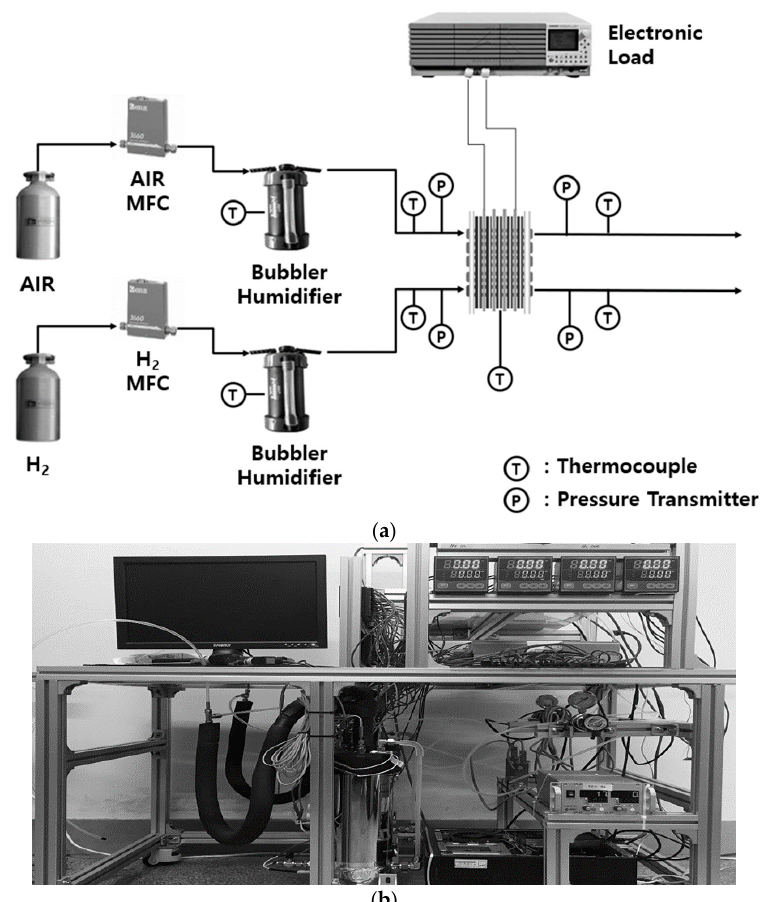
Figure 2. ( a ) Schematic of the polymer electrolyte membrane (PEM) fuel cell experiment; and ( b ) photograph of the experimental equipment.